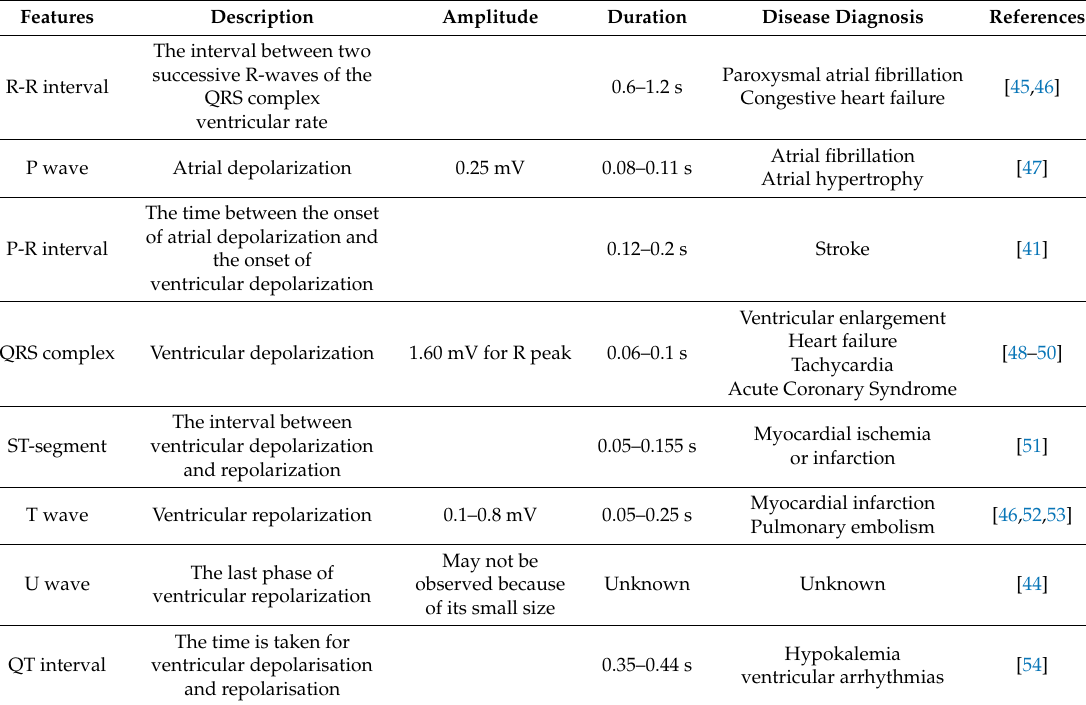
Figure 2. Cardiac electrical conduction system and the electrocardiogram signal. Table 1. ECG features and the normal values for a healthy